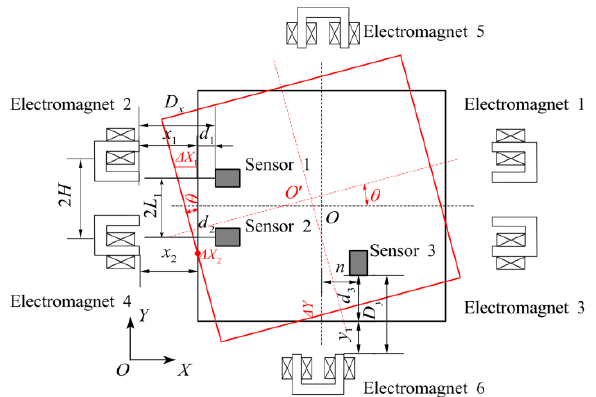
Figure 3. Magnetic flux path through the U ‐ core electromagnet.